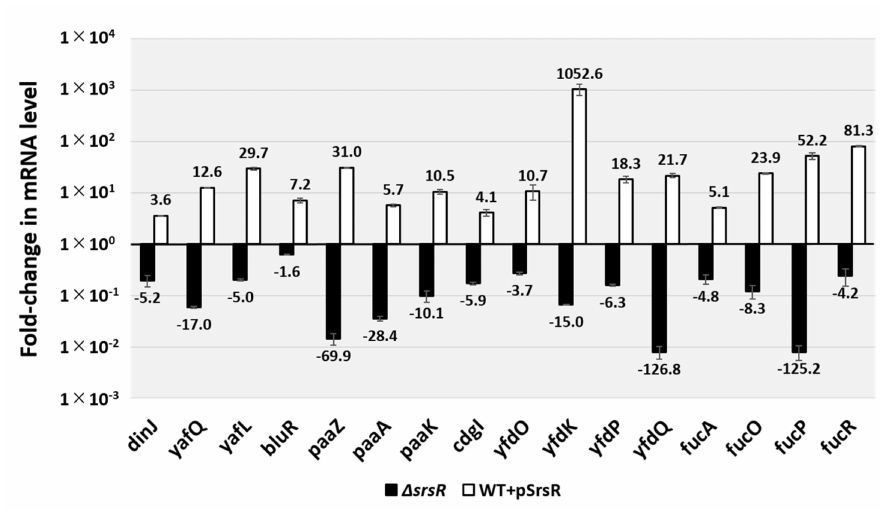
Figure 5. In vivo influence of srsR deletion or SrsR overexpression on transcription level of the SrsR targets by RT-qPCR. E. coli wild-type BW25113, its srsR -deleted mutant JW5476, the wild-type strain harboring the SrsR overexpression vector, and its empty vector were grown in the LB medium at 37 ◦ C. Total RNA was prepared from each strain at 24 h cultured cells and subjected to RT-qPCR analysis. RT-qPCR was repeated three times, and the average values are shown. The y -axis represents the relative level of mRNA of each SrsR target gene between the wild-type and the srsR mutant (black bar) as well the relative level between the wild-type harboring SrsR overexpression vector and empty vector (white bar); the ratio of 16S rRNA was set as an internal control between the compared strains. Each experiment was repeated at least three times, and the average means are shown.